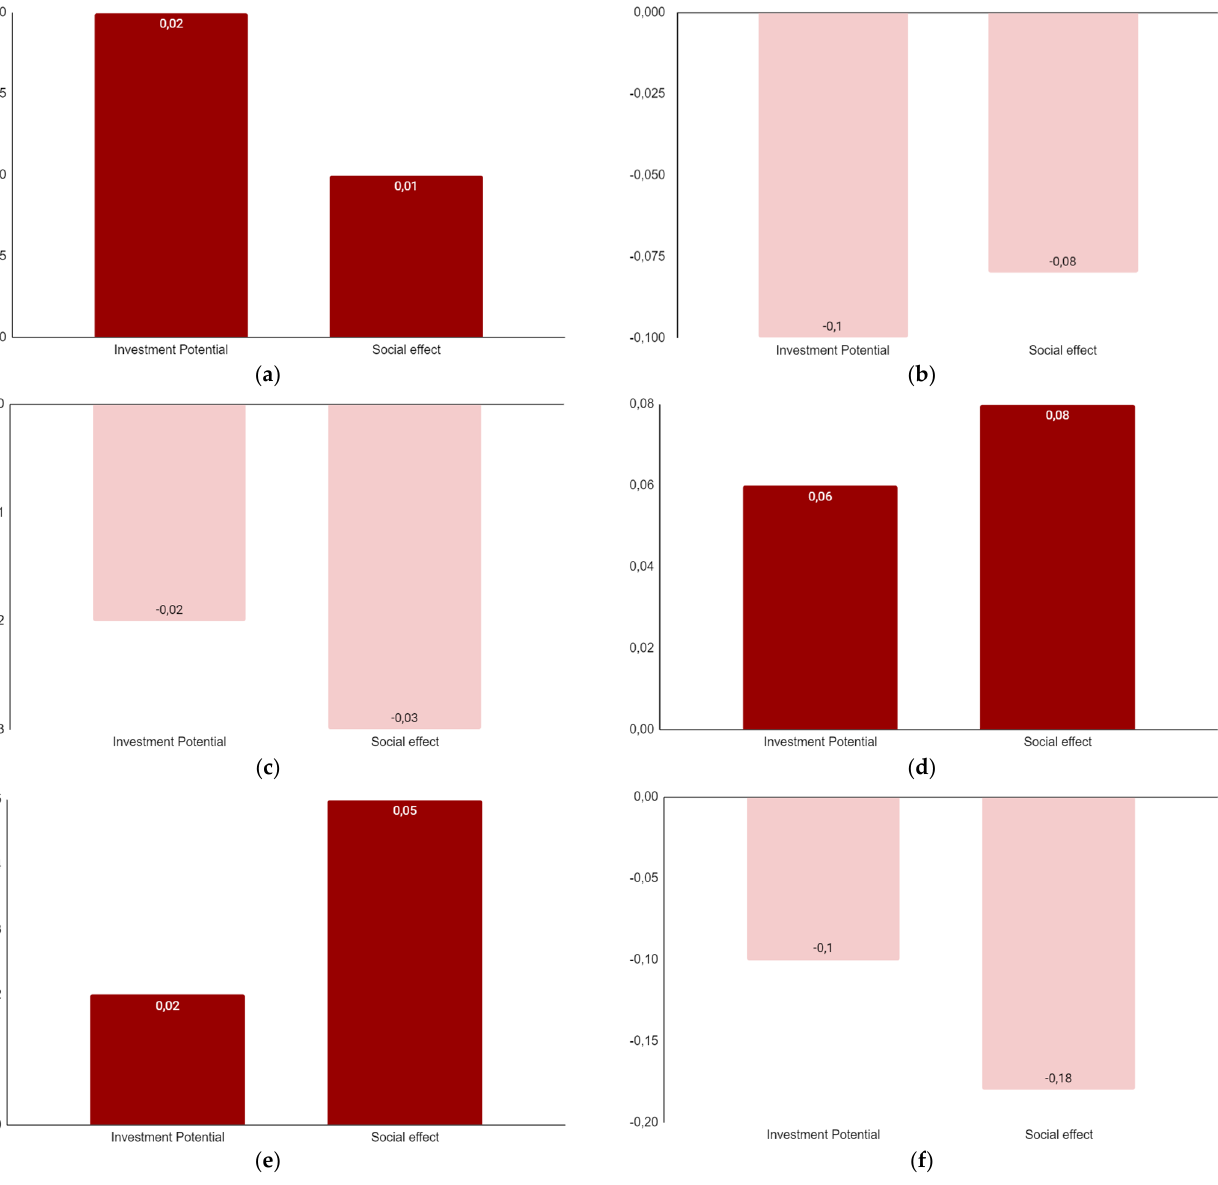
Figure 7. Simulation results for the following scenarios: ( a ) increasing the influence of the criterion “Land Use” on the target criteria; ( b ) reducing the influence of the criterion “Land Use” on the target criteria; ( c ) increasing the influence of the criteria “Size of Vacant Land Plots” and “Devaluation of Building Objects” on the target criteria; ( d ) reducing the influence of the criteria “Size of Vacant Land Plots” and “Devaluation of Building Objects” on the target criteria; ( e ) increasing the influence of the “Owner’s Authority” criterion on the target criteria; ( f ) reducing the influence of the “Owner’s Authority” criterion on the target criteria.